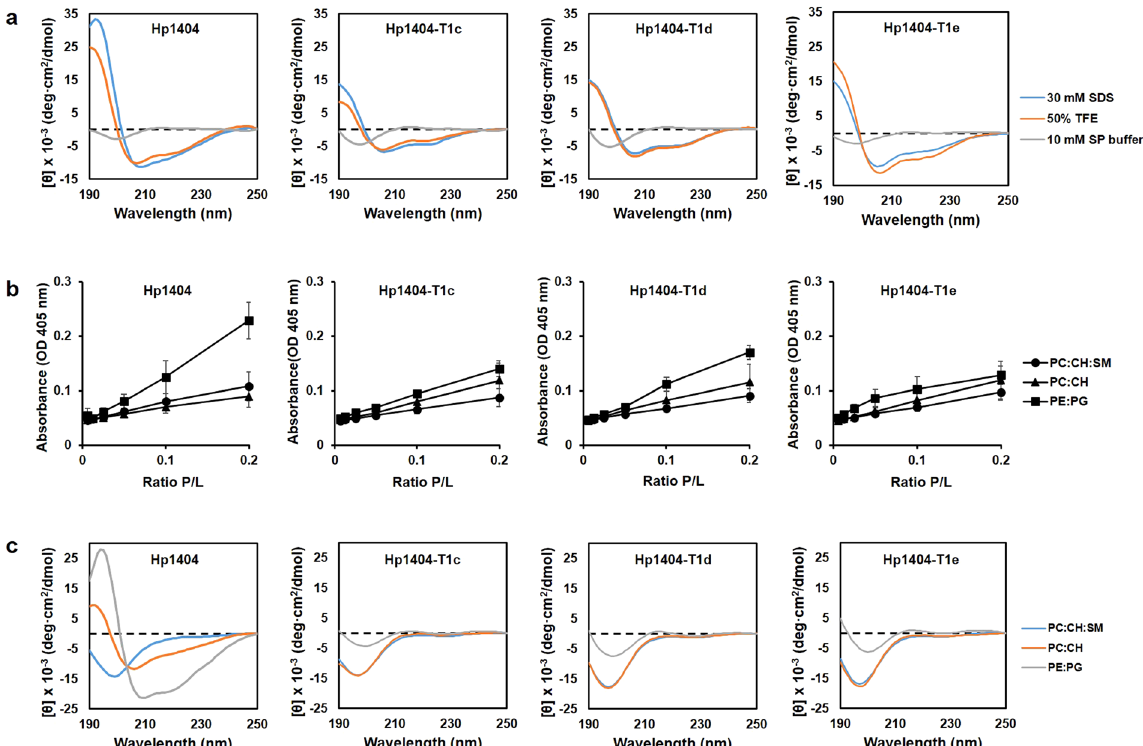
Figure 5. Circular dichroism (CD) spectra and large unilamellar vesicle (LUV) aggregation. ( a ) Peptide levels were measured in 30 mM SDS, which mimics the negatively charged prokaryotic membrane environment, or 50% TFE, which mimics the hydrophobic environment of the microbial membrane. ( b ) LUV aggregation. Solutions containing various concentrations of peptides were added to 400 µ M suspensions of PE:PG (7:3, w/w), PC:CH:SM (1:1:1, w/w), or PC:CH (2:1, w/w) LUVs. ( c ) CD spectra of peptides in the presence of LUVs composed of PC:CH:SM (1:1:1, w/w), PC:CH (10:1, w/w), or PE:PG (7:3, w/w)